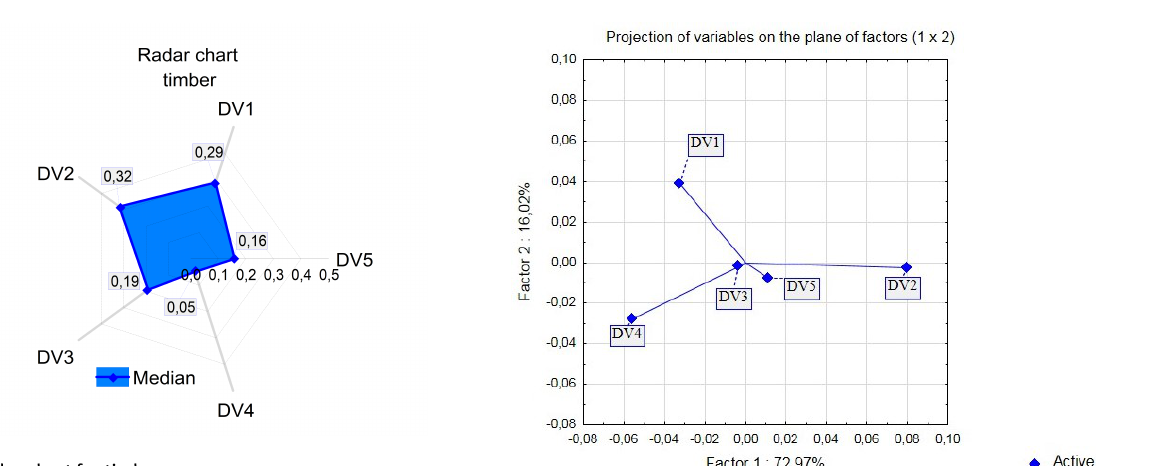
Figure 5: Radar chart for timber. Table 4: Surface areas of radar charts.